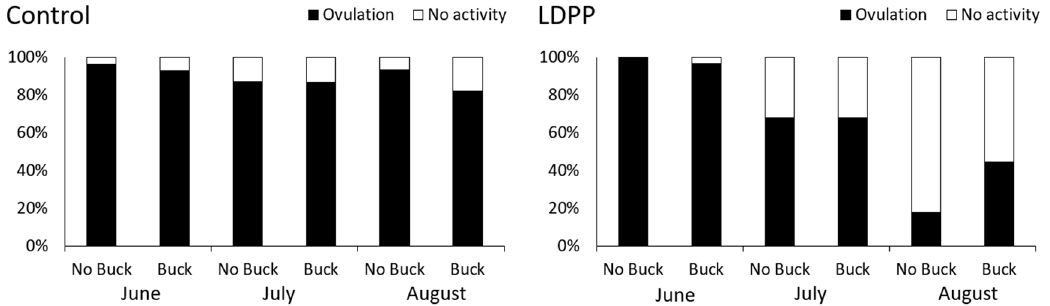
Figure 4. Effect of ambient lighting (Control) or long day photoperiod (LDPP) and buck exposure on ovulatory activity in lactating goats in winter in the Southern Hemisphere ( n = 27–30 for each photoperiod × buck × month group).